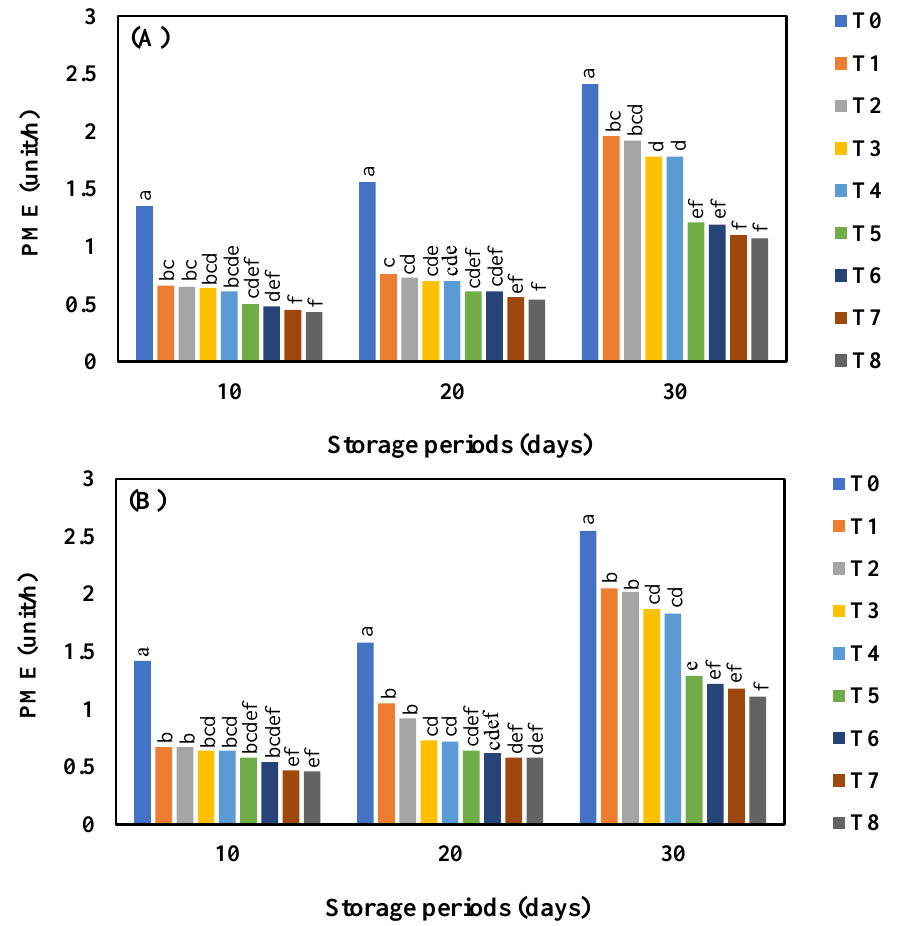
Figure 8. Effect of AgNO 3 and Ag-NPs on Pectin methylestraese (PME) activity in Shine Muscat ( A ) and Kyoho ( B ) grape varieties during 30 days cold storage .